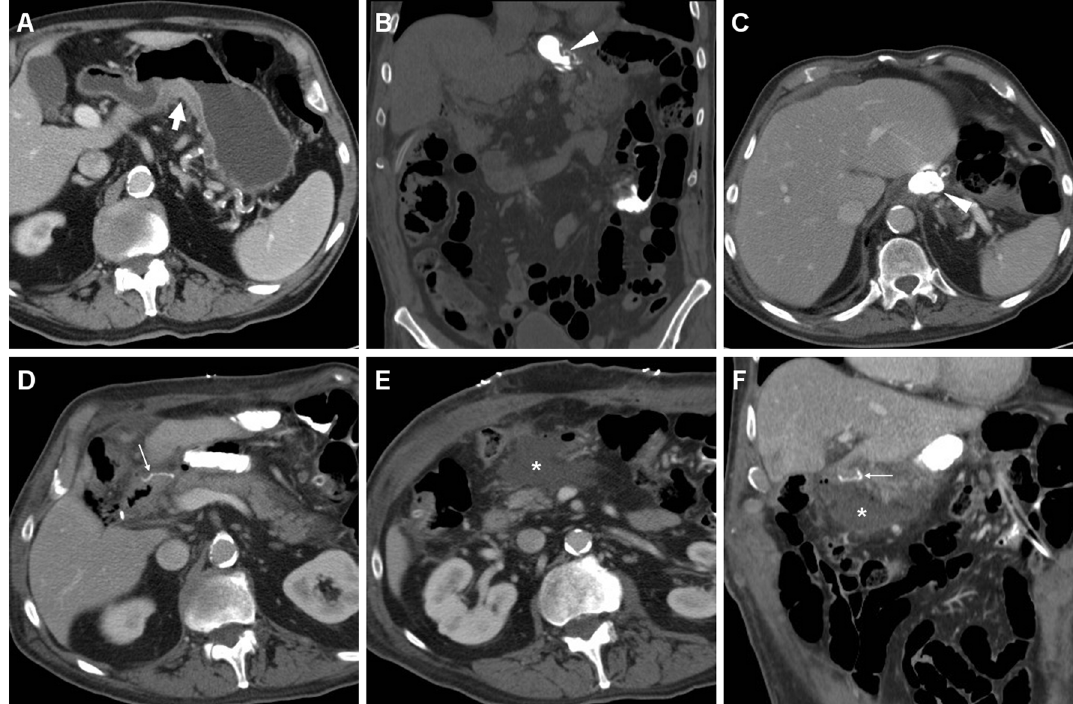
Fig. 9 An 81-year-old male with T3 N2 cancer of the lessergastric curvature (thick arrow) as preoperatively depicted by CTwith oral water distension (A) underwent total gastrectomywithRoux-en-Yreconstruction.On9thPODCT was performed because of bile from drainage: unenhanced (B) and post contrast (C-F) scans with oral contrast showed normally opacified and patent